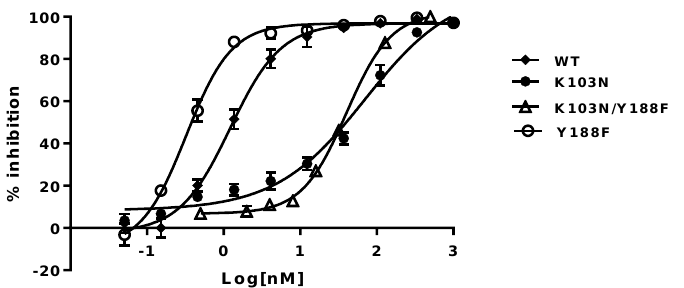
Figure 4. Inhibition curves of EFV against K103 and/or Y188F mutants. The error bars are in means ± standard deviation with more than three replicates.